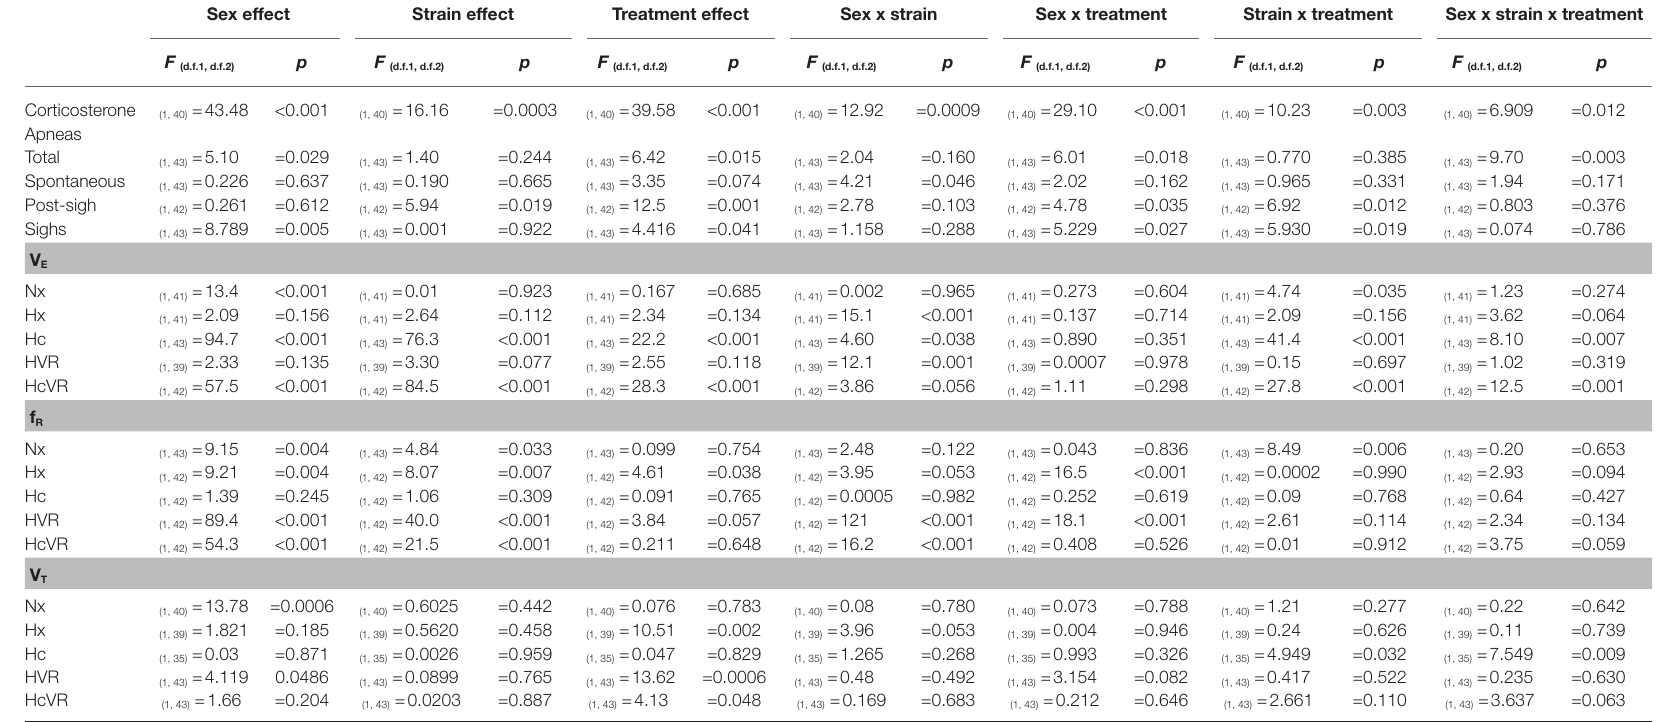
TABLE 1 | Three-way ANOVA results for the effect of sex (males vs. females), strain (WT vs. Tg21), and treatment (control vs. NMS) on the concentration of CORT; number of total, spontaneous, and post-sigh apneas; number of sighs; and minute ventilation (V E ), respiratory frequency ( f R ), and tidal volume (V T ) during Nx, Hx, Hc, HVR, and HcVR. Sex effect Strain effect Treatment effect Sex x strain Sex x treatment Strain x treatment Sex x strain x treatment p p F (d.f.1, d.f.2) Corticosterone (1, 40) =